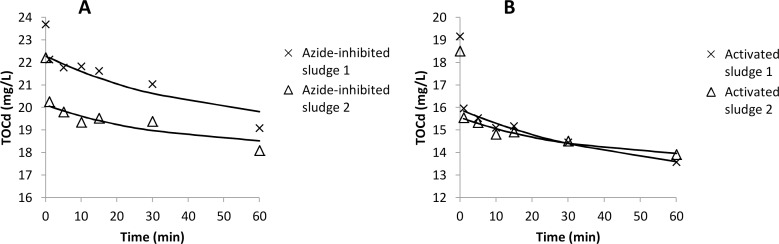
Concentration of TOCd in sorption tests with azide-inhibited (A) and live activated sludge (B).The solid lines show fits using 1st-order kinetics for the measurements points between 1 min and 60 min. Two repeated tests were carried out with each type of sludge.